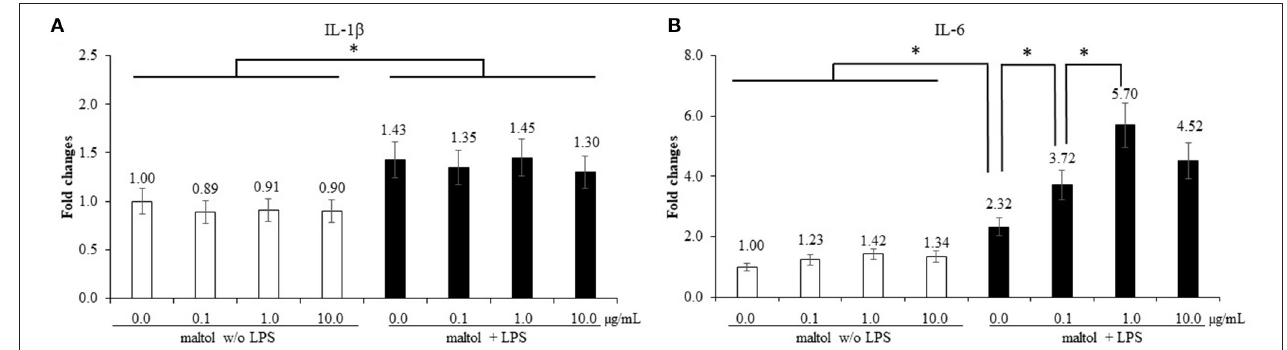
FIGURE 2 | Secretion of pro-inflammatory cytokines in chicken epithelial cells (IEC) by LPS and maltol. Each bar represents the mean ± SEM ( n = 3). Transcript levels of the cytokines were measured using quantitative RT-PCR and normalized to GAPDH transcript levels. Significant results are marked as * ( P < 0.05). LPS, lipopolysaccharide.